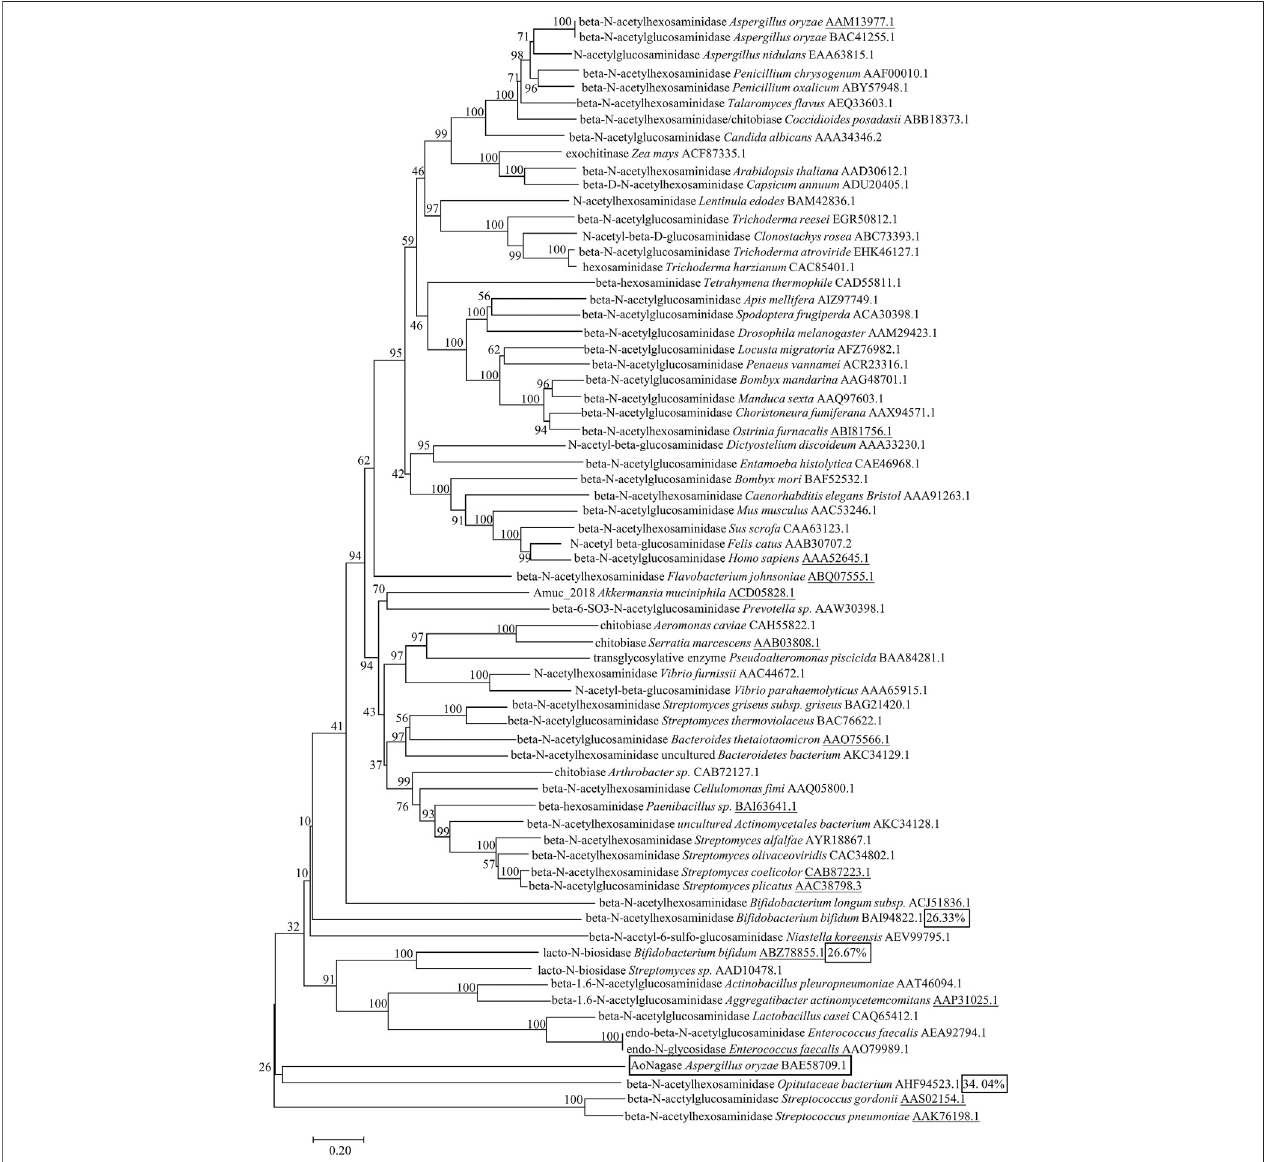
FIGURE1| PhylogeneticanalysisofAoNagase with67proteinsfrom GHfamily 20in theCAZydatabases.Neighbor-joiningtreeshows phylogenetic relationships between AoNagase and other GH family 20 members from Uniprot and Protein Date Bank entries. All sequences from GH family 20 were labeled with names and GenBank accession numbers. The underlines indicate the proteins with known 3D